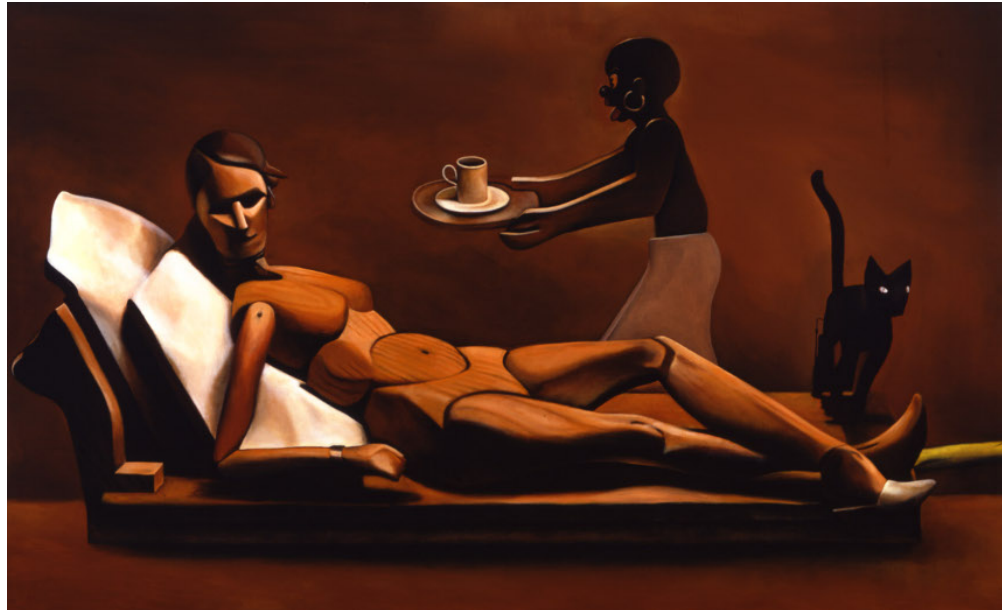
Figure 3: Rob Scholte, Utopia , 1986